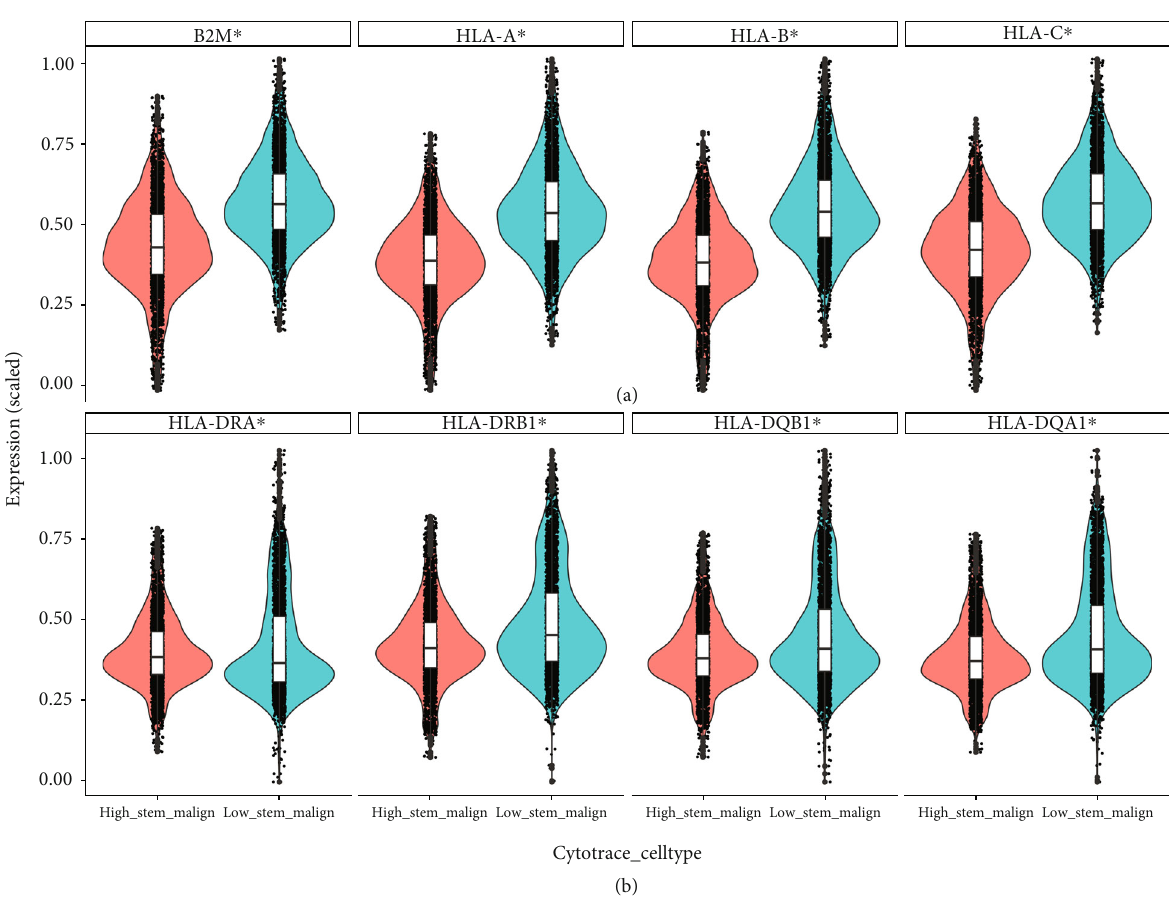
Figure 3: Comparison of MHC pathway pro fi le between high stemness and low stemness iCCA cells. (a) Violin plot of MHC I pathway- related genes. (b) Violin plot of MHC II pathway-related genes. ∗ indicates P < 0 : 05